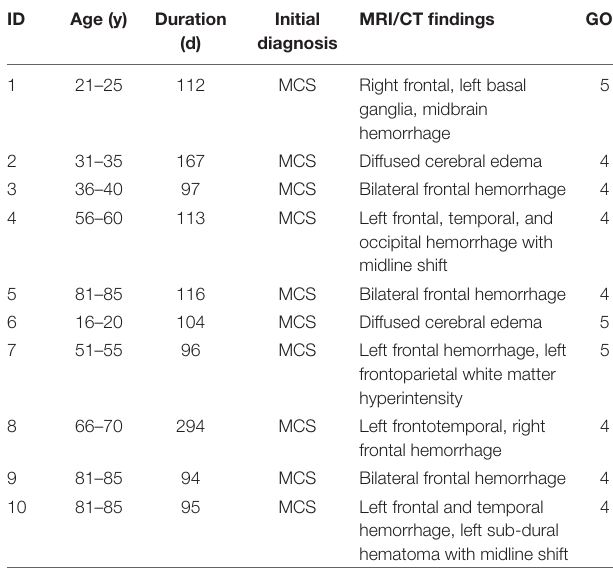
TABLE 1 | Clinical characteristics of the patients.